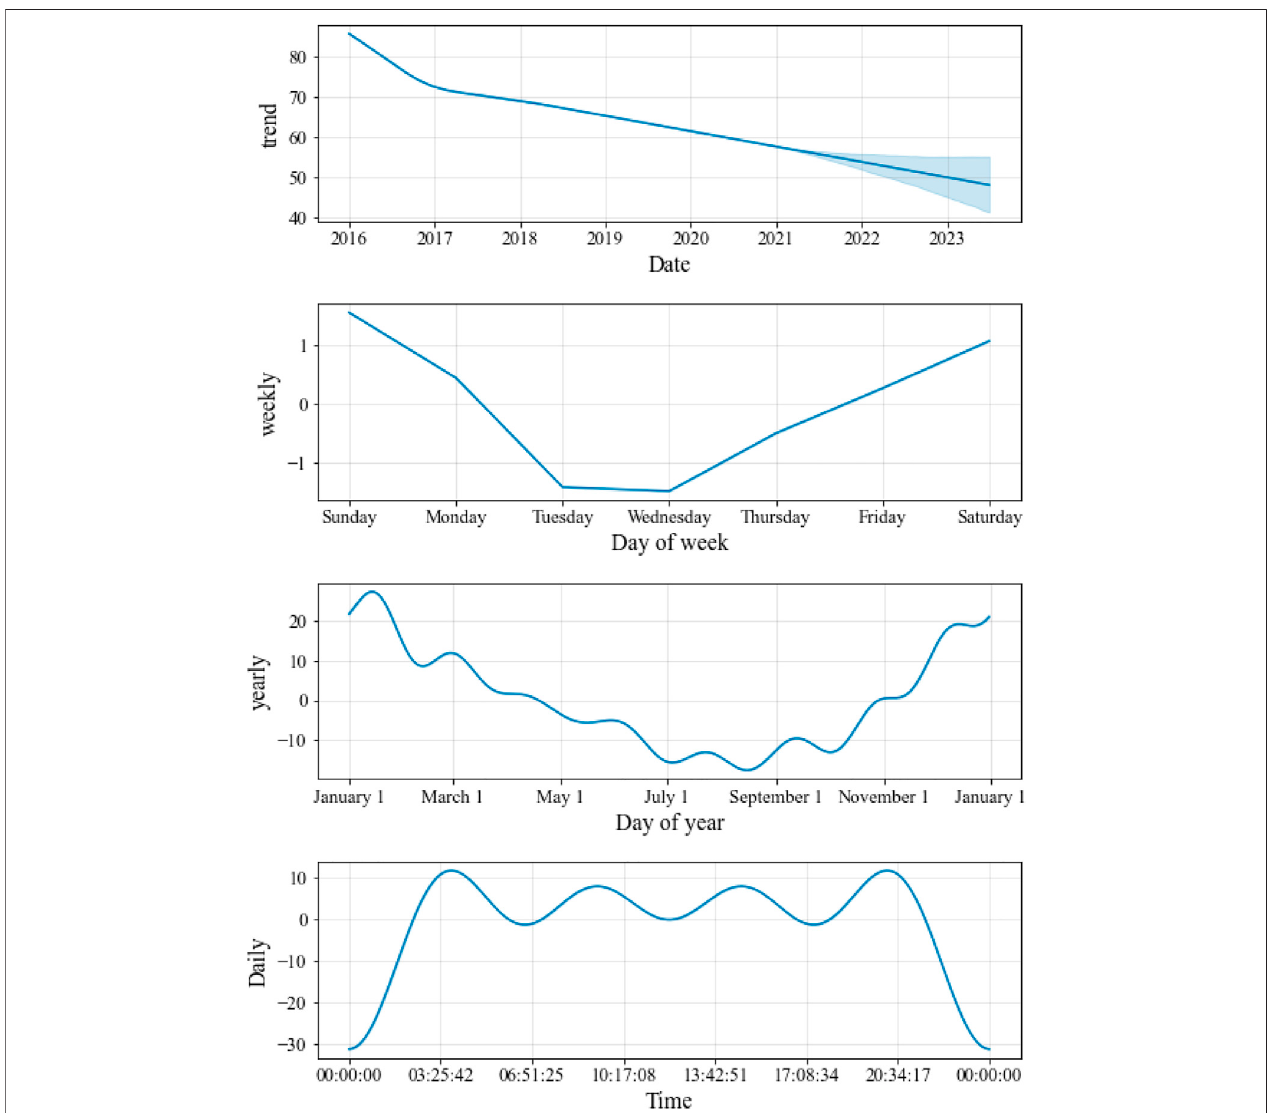
FIGURE 2 | Components of the Model (PM 2.5 trends graph, overall trend, yearly, weekly and daily).